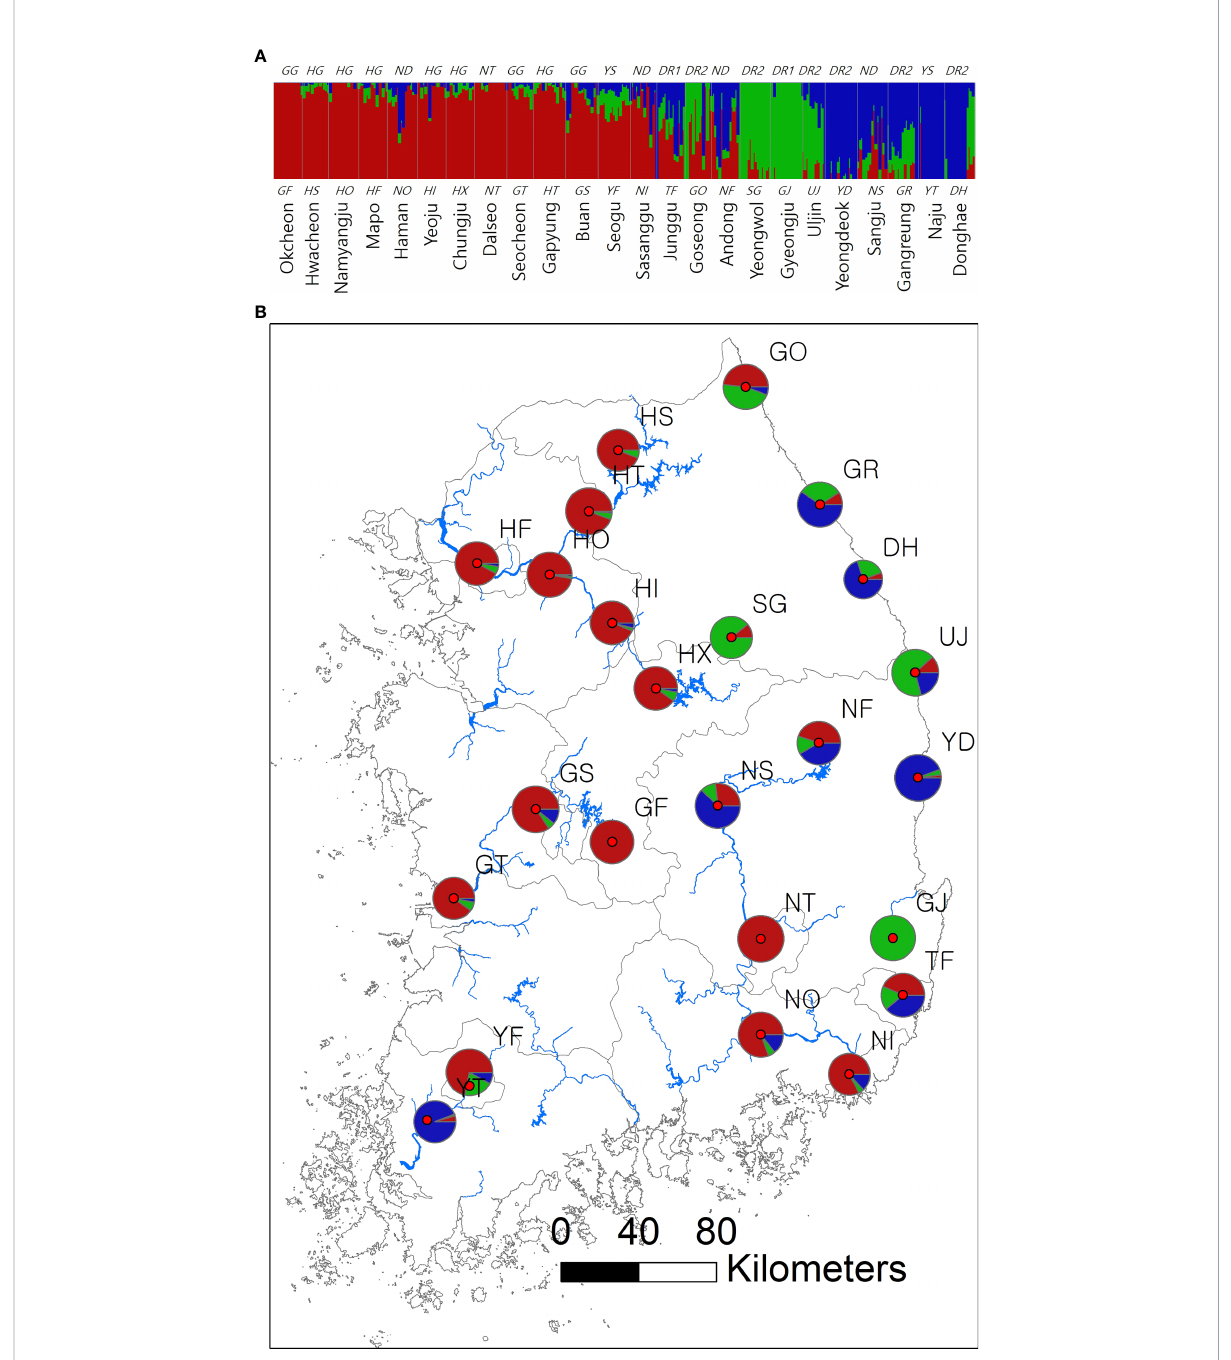
FIGURE 1 Spatial structure of 24 Sicyos angulatus populations throughout South Korea. (A) The bar chart of the clustering assignment for K = 3 assessed from fastSTRUCTURE based on 2,696 SNP loci sampled across 346 burcucumber genotypes. The vertical white lines separate each population from one another. Colors indicate locus assignment into each of the three clustering groups. See Table 1 for population abbreviations. (B) Map of burcucumber collection sites in South Korea. Pie charts summarized the clustering assignments of individual genotypes within each population. The pie sizes re fl ect the relative sample size of each